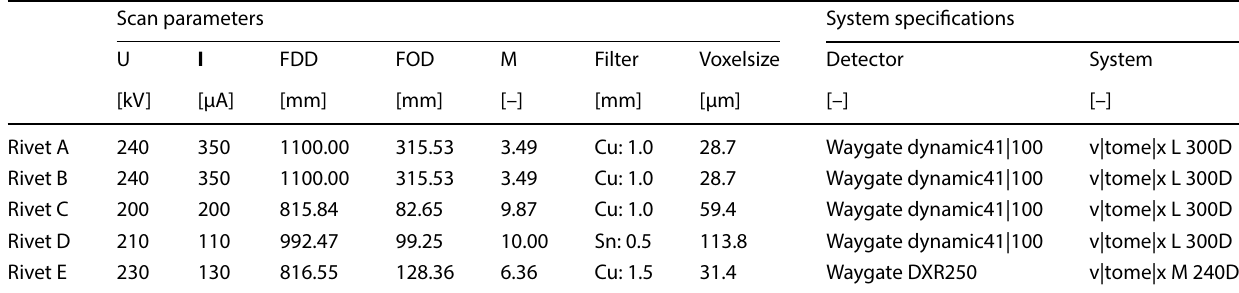
Table 1 Scan parameters and additional information relevant for acquiring the CT-volumes on which the algorithm was tested. Here, U: stands for the peak acceleration voltage, I: for tube current, FDD: